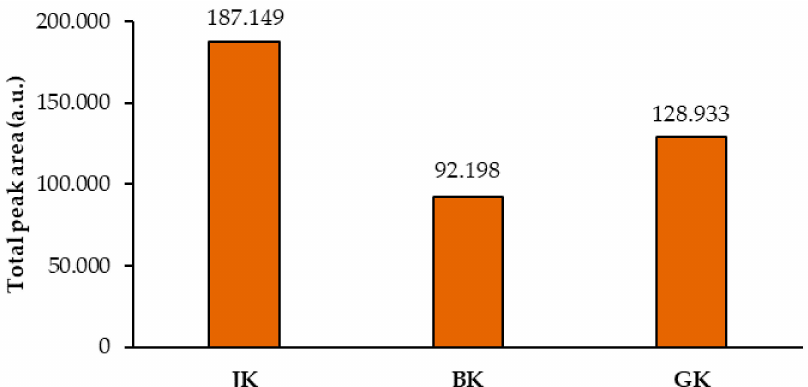
Figure 7. Comparison of the means of the total peak areas of proanthocyanidins (blue bands in chromatograms) for STSs from rhizomes of Japanese (JK), Bohemian (BK), and giant (GK) knotweed. The mean of the total peak areas was calculated from the total peak areas of the videodensitograms of two equal applications of the same STS on the HPTLC silica gel plate (Figure 3) after the devel- opment with toluene–acetone–formic acid (3:6:1, v/v ) and after the derivatization with DMACA detection